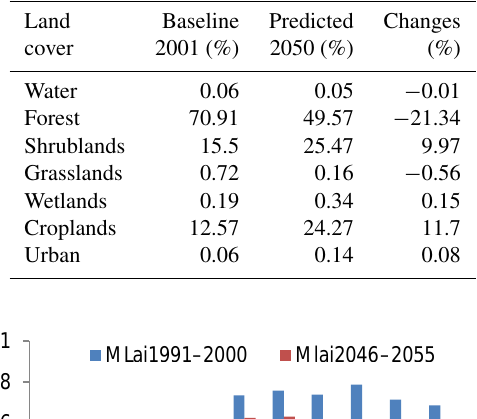
Table 3. Future land cover changes of 2050 created through neural networks compared with the baseline map of 2001 image in DRB (area percent: %).